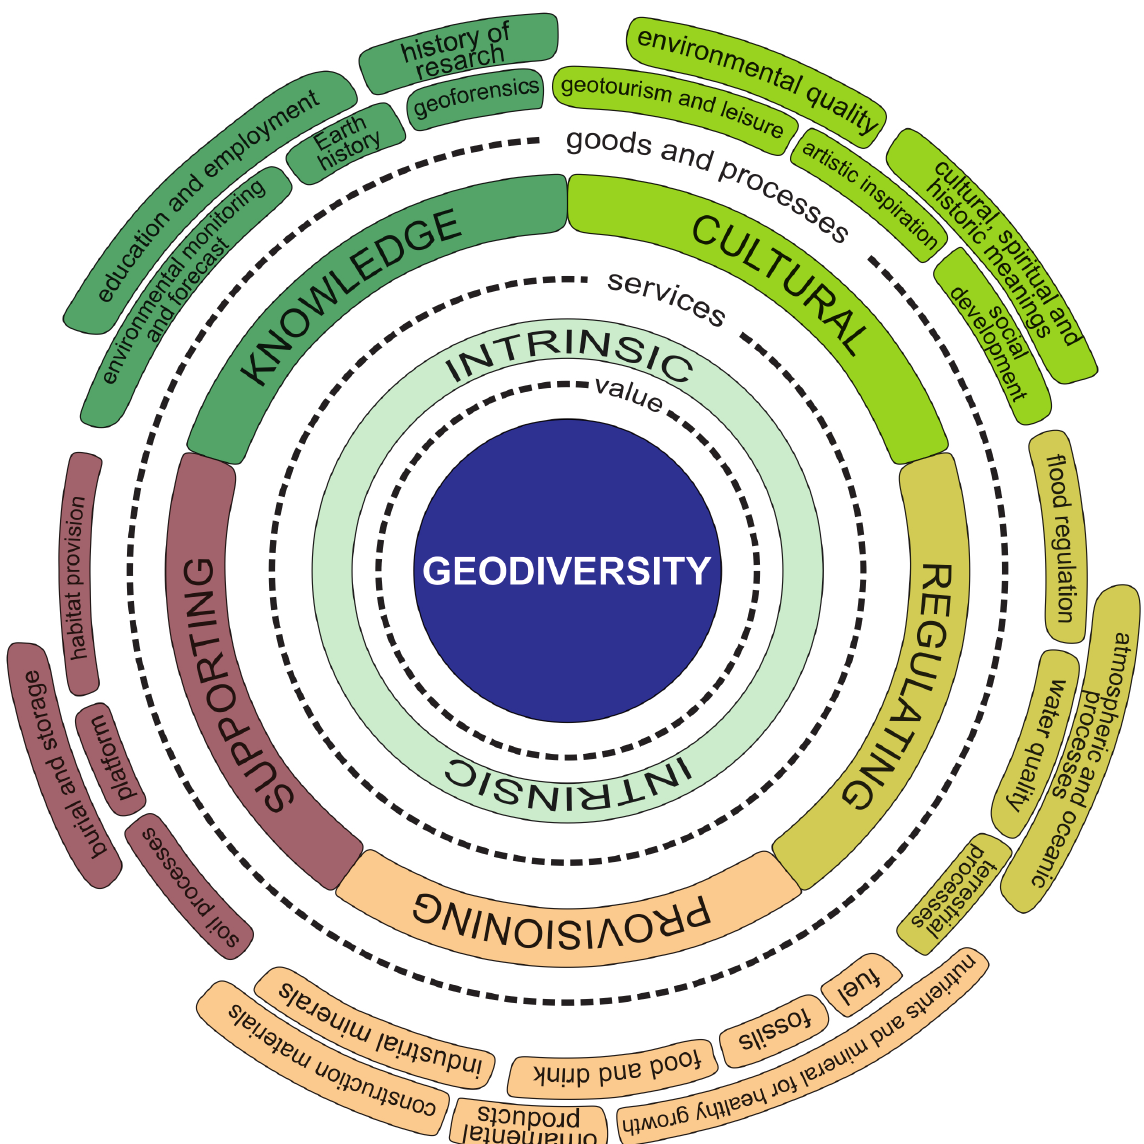
Figure 2 . Simplified diagram of geodiversity ecosystem services as elucidated by Gray (2013). Modified from Silva